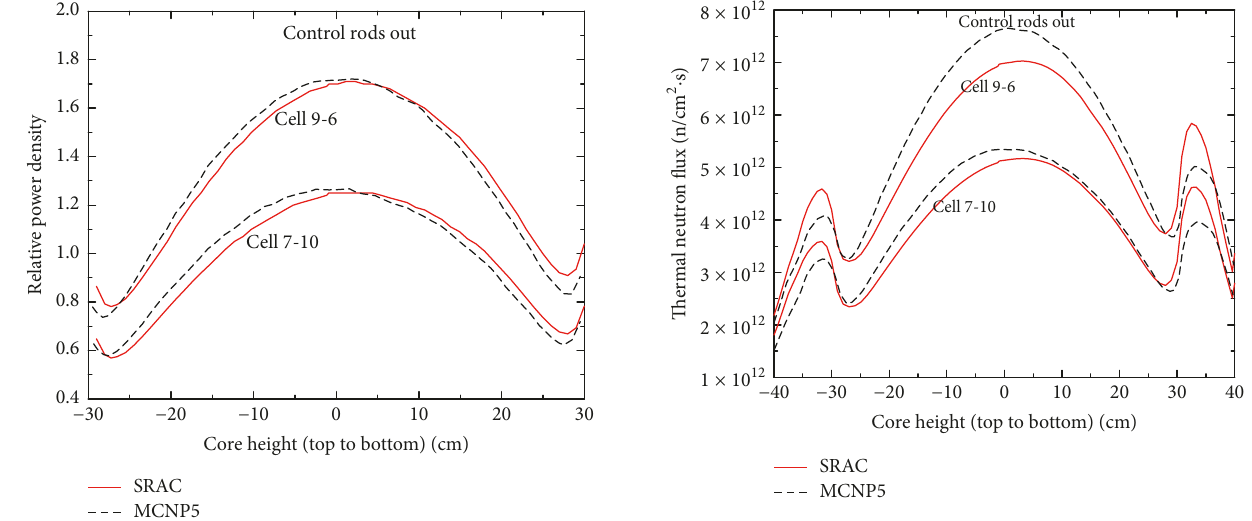
Figure 11: Thermal neutron flux distribution along the fuel bundles 7-10 and 9-6 in the case of complete withdrawal of control rods.